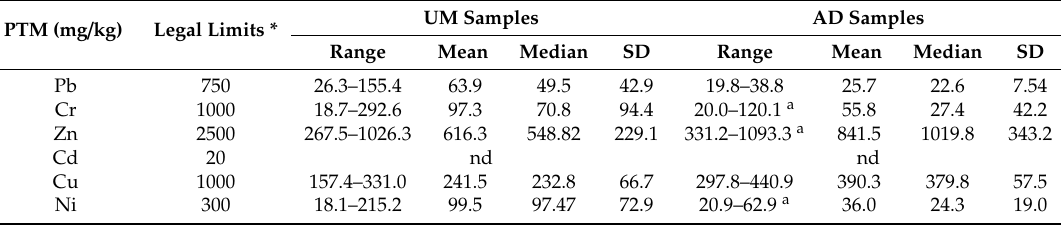
Table 4. Potentially toxic metals (PTM) concentration (mg / kg) in urban mixed (UM) and anaerobic digestion (AD) samples and legal limits according to Portuguese law.